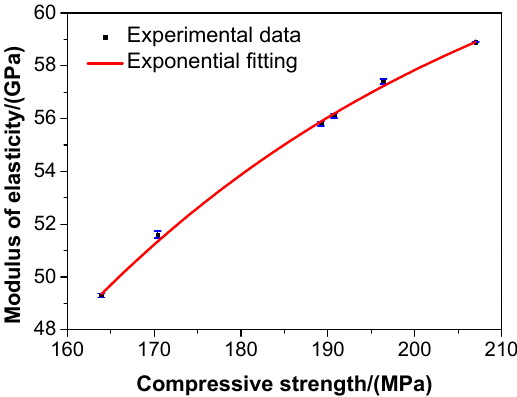
Figure 8. The relationship between the compressive strength and Young’s modulus of the UHPC.